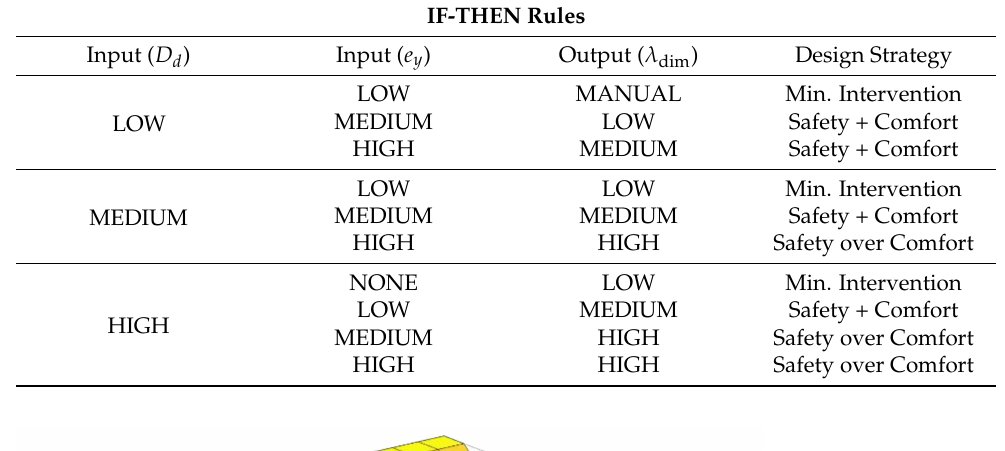
Table 6. FIS for the arbitration module (IF-THEN rules).